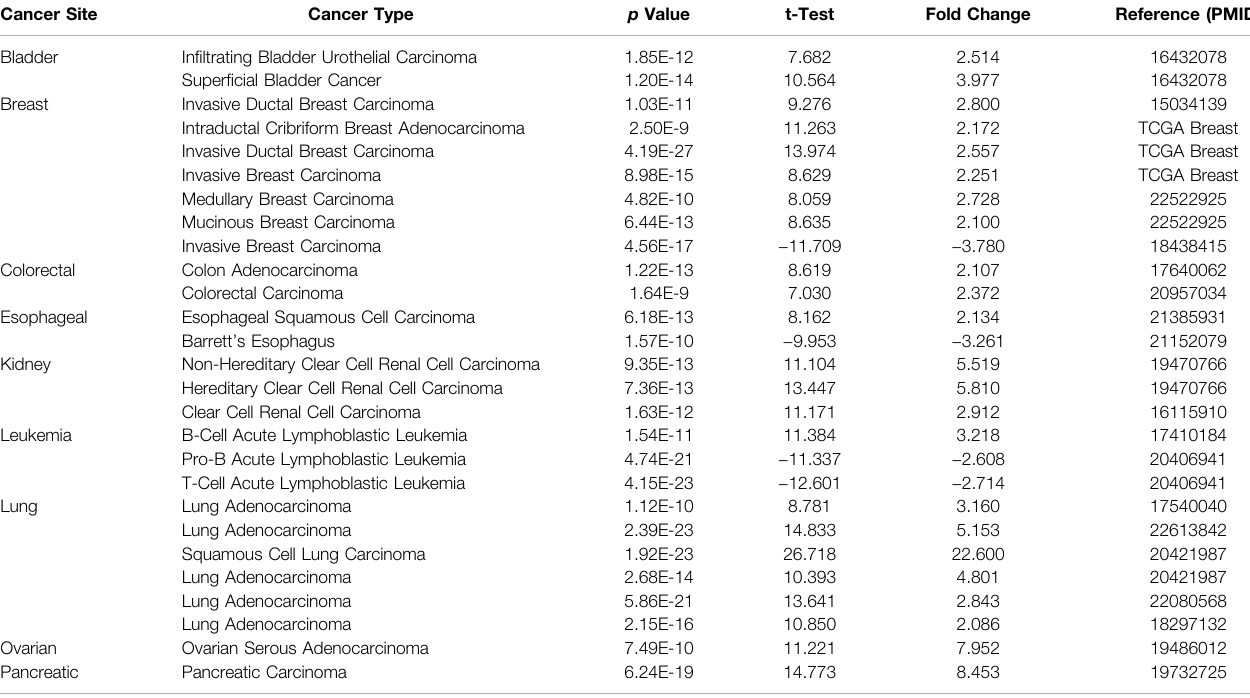
TABLE 1 | SLC2A1 expression in cancerous versus normal tissue in